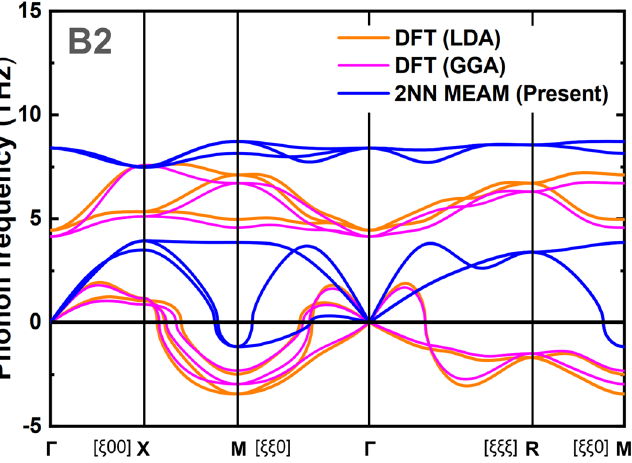
Figure 4. Phonon spectra of B2 structure PtTi predicted based on the harmonic approximation. The spectra obtained from the present DFT calculation (LDA and GGA), and the present 2NN MEAM potential are compared.